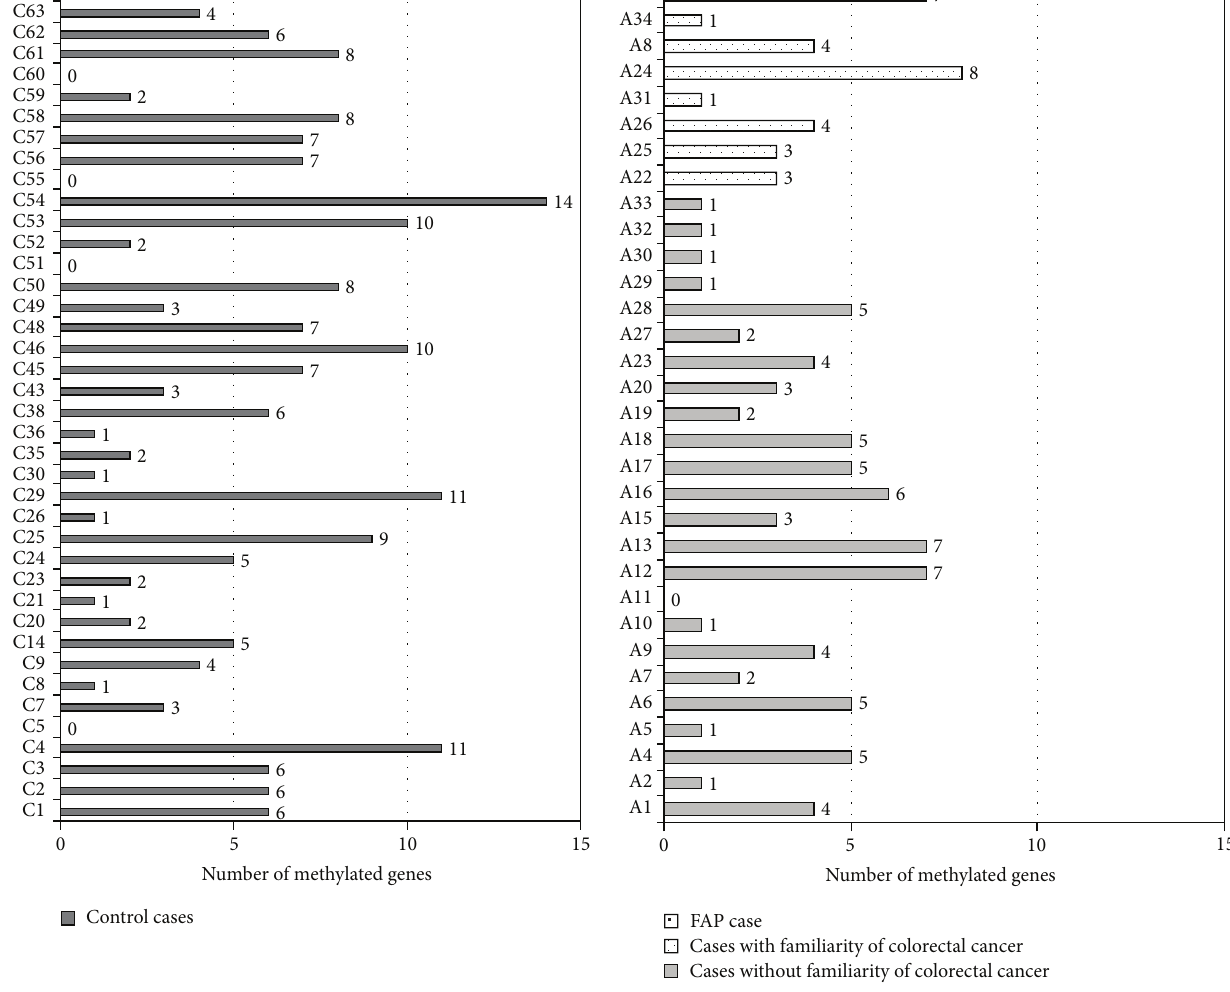
Figure 2: Number of methylated genes in control cases and in early onset colorectal